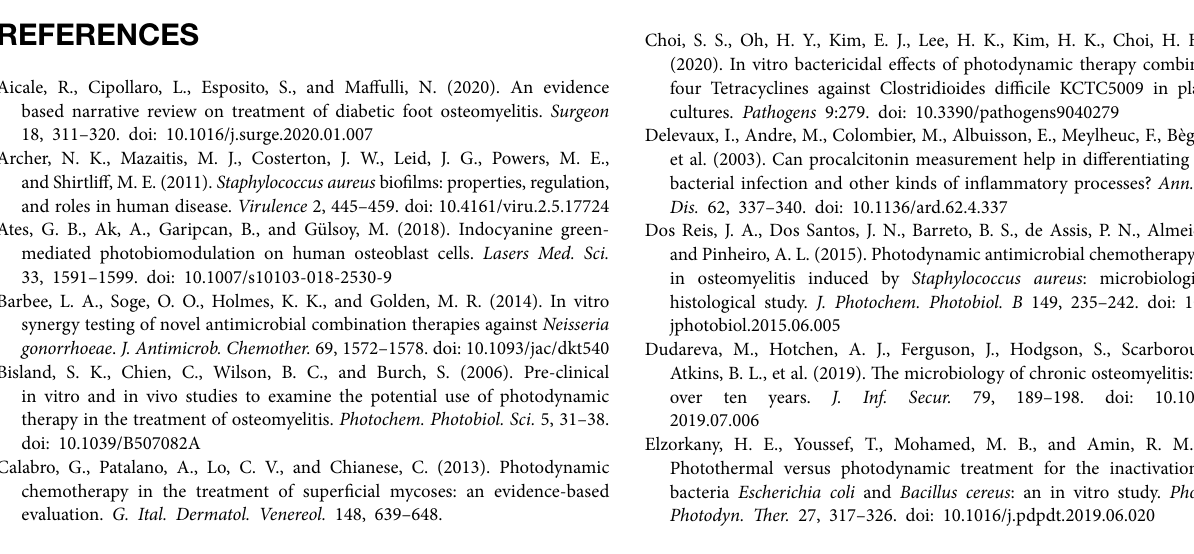
Supplementary Table S1 | Results of drug sensitivity test of MRSA. Supplementary Figure S1 | Chemical structural formula of